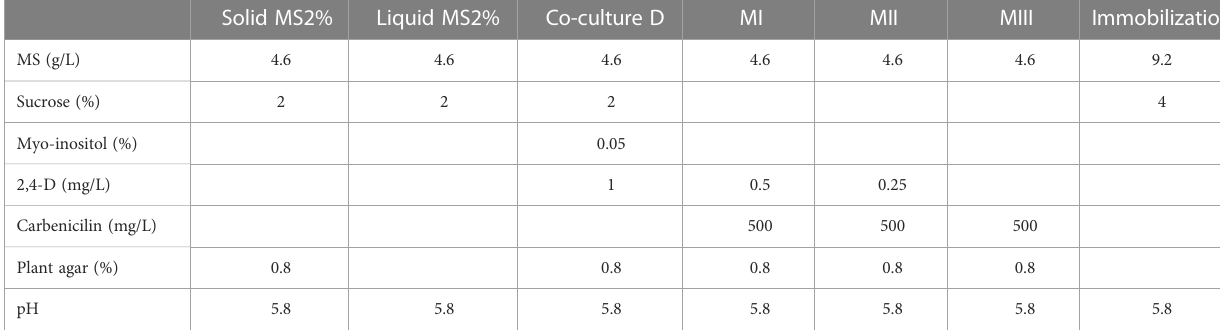
TABLE 1 Composition of the seed germination and plant in vitro culture media used for the carrot transformation protocol